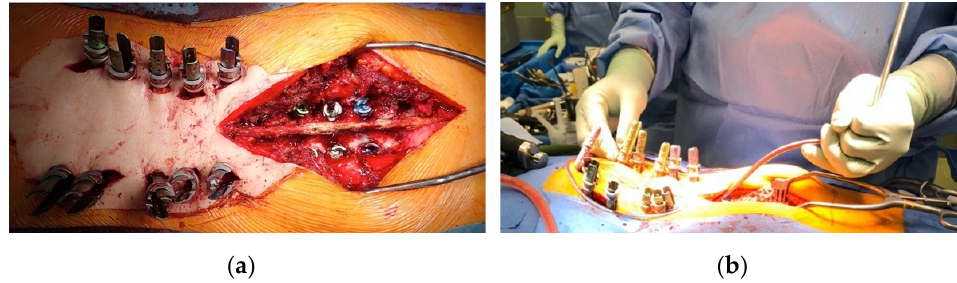
Figure 2. Intraoperative imaging demonstrating hybrid PF for ASD. The PPSs were inserted into the L2 to the ilium, and mini-open TLIF was performed on both sides at L5–S1. Thereafter, open poste- rior-lateral fusion was performed on T10–L1 using the open pedicle screws ( a ). The optimally bent rods were inserted beneath the muscle layer from the cranial side. After going through the blade of the PPS, the set screws were placed sequentially from the S2AIS toward the cranial side with the rod rotation maneuver and cantilever technique ( b ). rod rotation maneuver and cantilever technique ( b